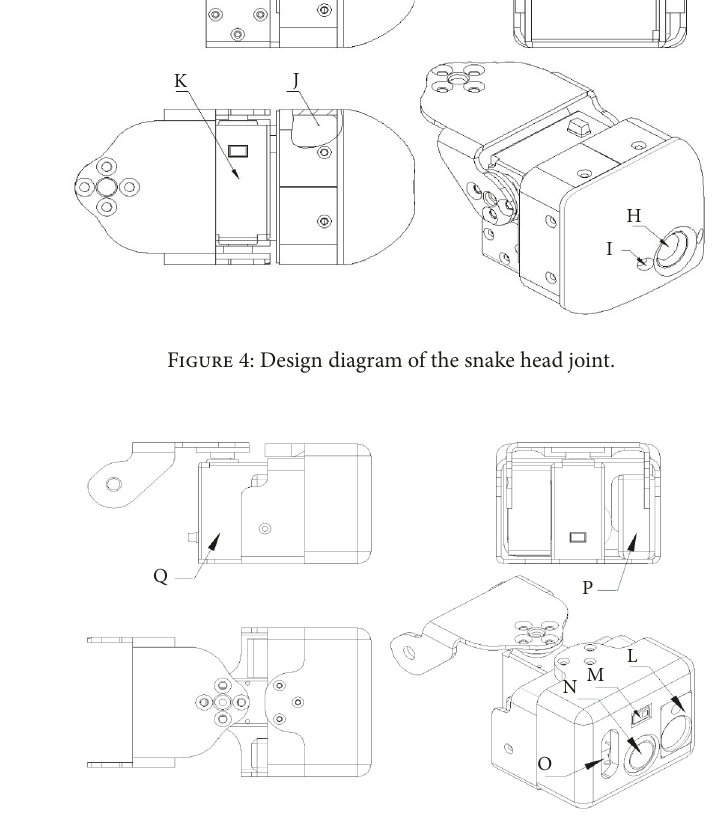
Figure 5: Design diagram of the snake tail